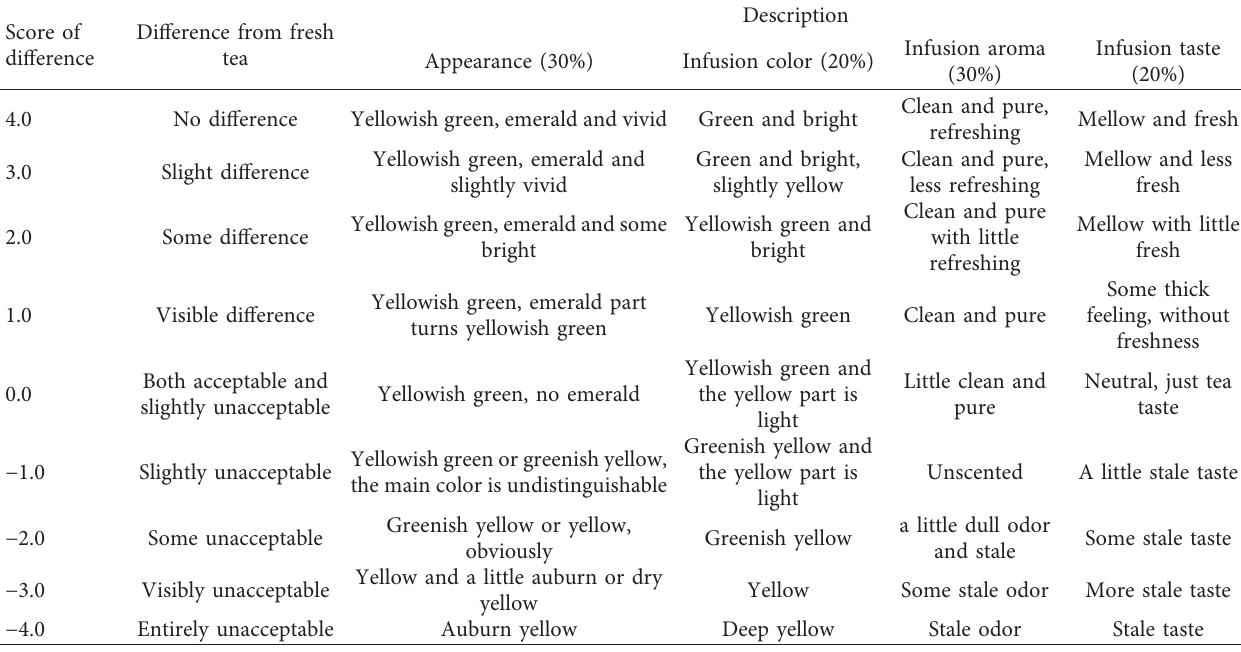
Table 2: Establishment of nine-point scale and sensory attributes description.